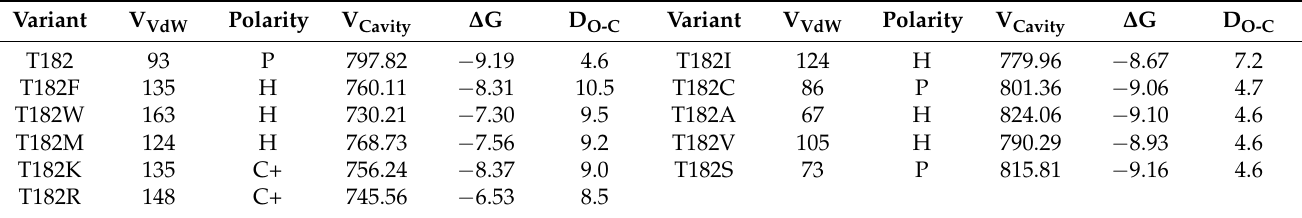
Table 3. Binding properties of wild type and variants of PentS with